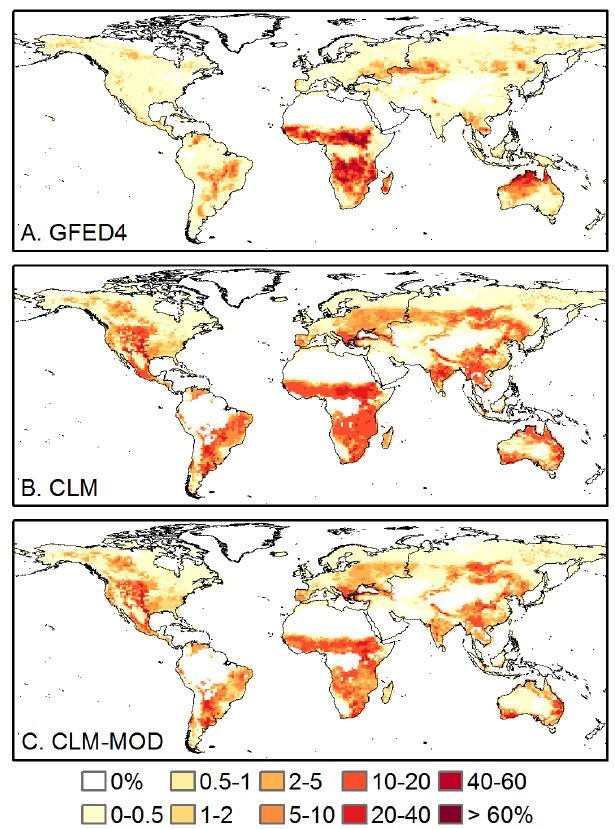
Figure 9. Average burned area fraction per year across the time period where data was available (1996–2010) for GFED4, CLM, and CLM-MOD, and the differences between these